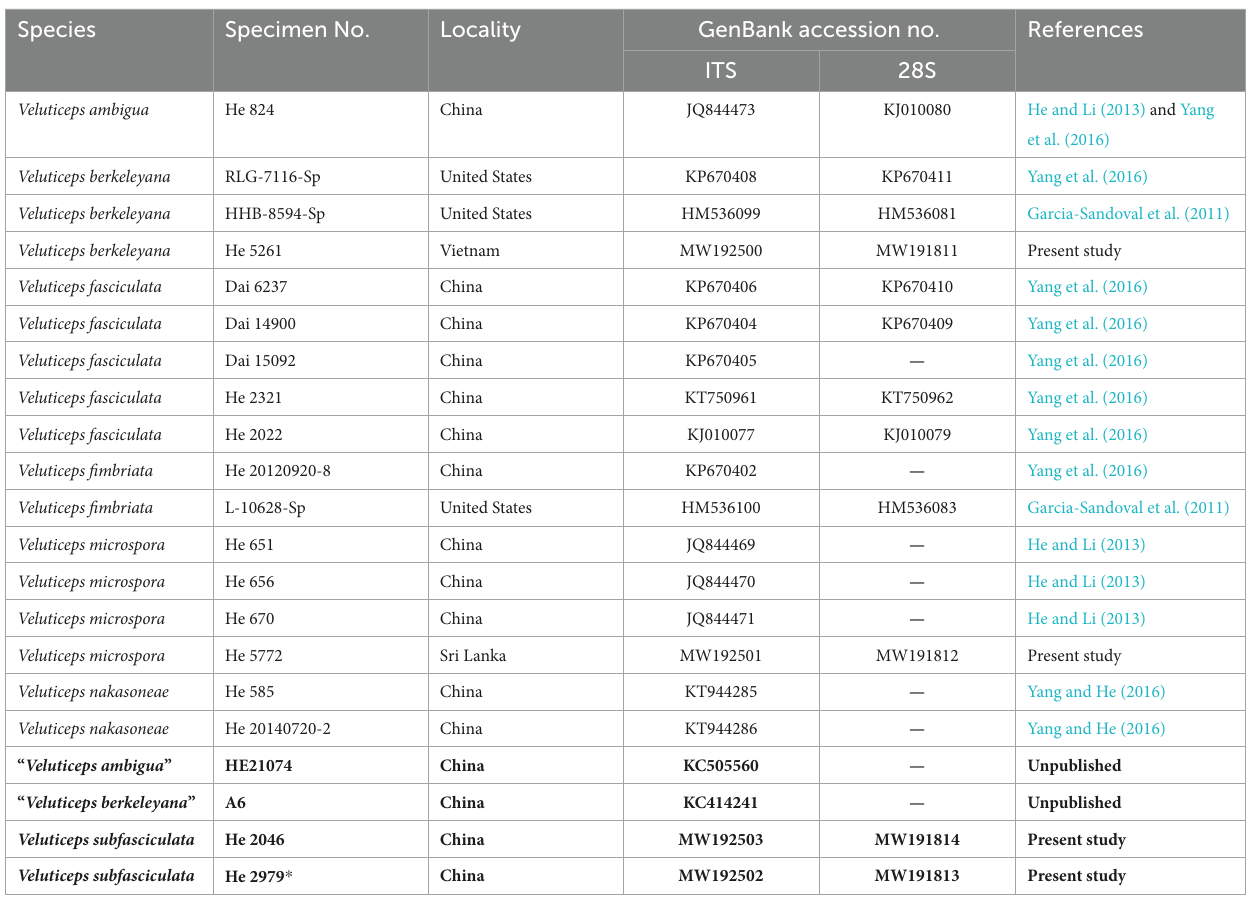
(Table 1). The aligned length was 2040 characters, of which 269 were parsimony informative. MP analysis yielded eight